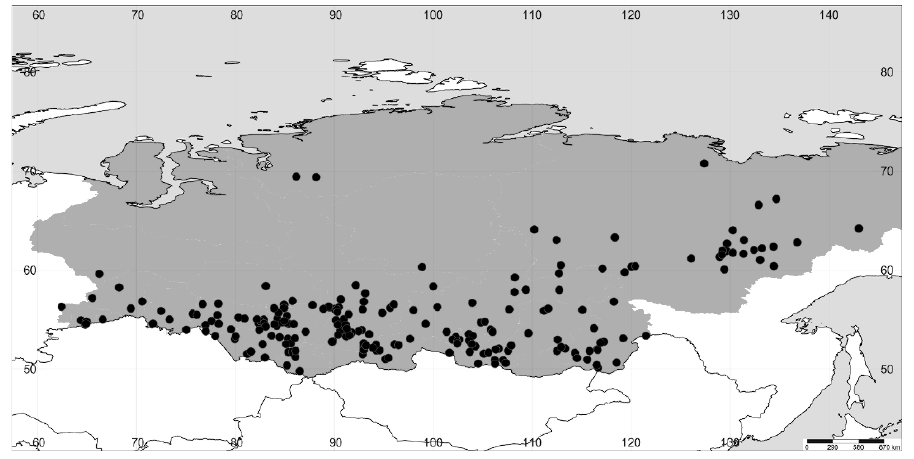
Figure 1. The distribution of A. amaranthoides in Siberia (the region itself is colored gray).